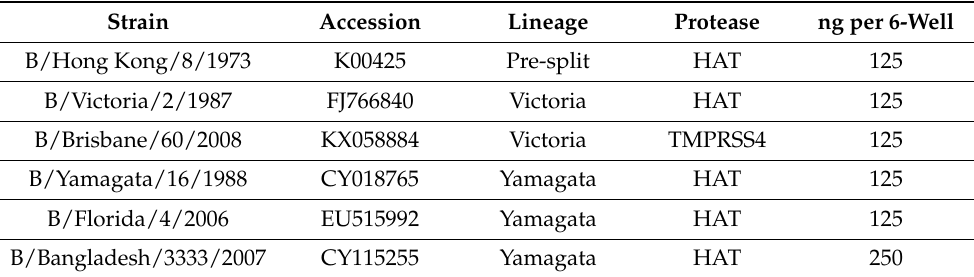
Table 1. Influenza B strains, accession numbers, lineage, protease type and quantity required for production in 6-well format are displayed. Human Airway Trypsin (HAT) and Transmembrane protease, serine 4 (TMPRSS4) expression plasmids were co-transfected with other plasmids to allow maturation of HA0 to HA1/2 inside producer